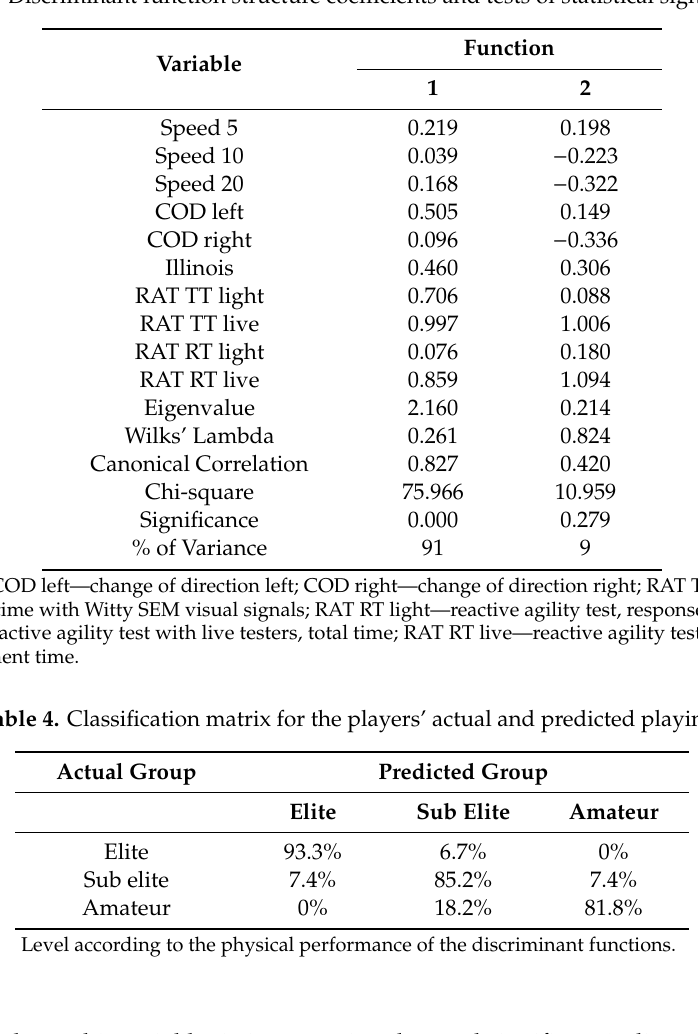
Level according to the physical performance of the discriminant